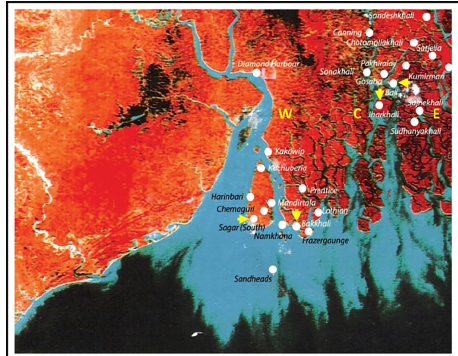
Figure 2. A satellite image of the study area (Hooghly-Matla estuarine complex of Indian Sundarbans) pointing to the selected study sites. The map shows three sectors of Indian Sundarbans, namely the western (W) (hyposaline), central (C) (hypersaline), and eastern (E) (hyposaline) sectors with four selected stations (Sagar South, Bakkhali, Jharkhali, and Bali Island) indicated with bold yellow arrowheads (source: Modified after Mitra,